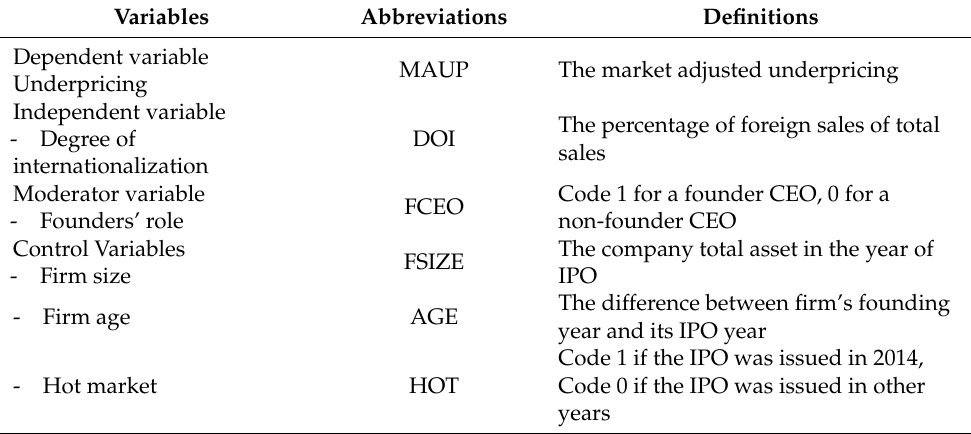
Table 3. Variables’